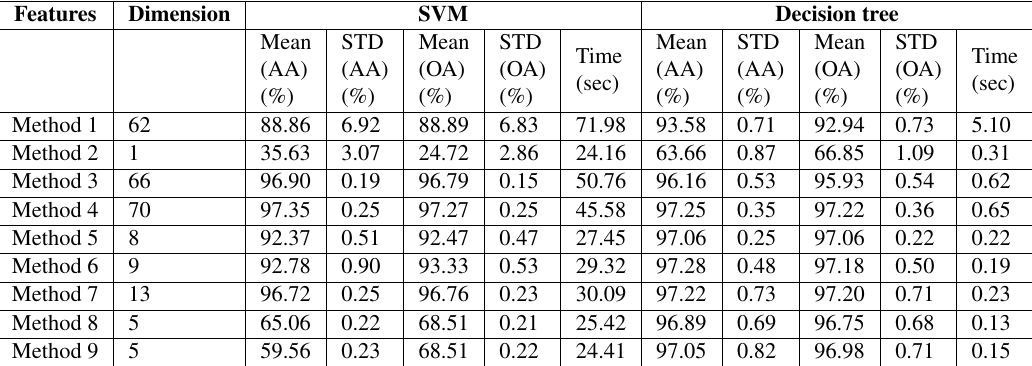
Table 5. Classification accuracies from SVM and decision